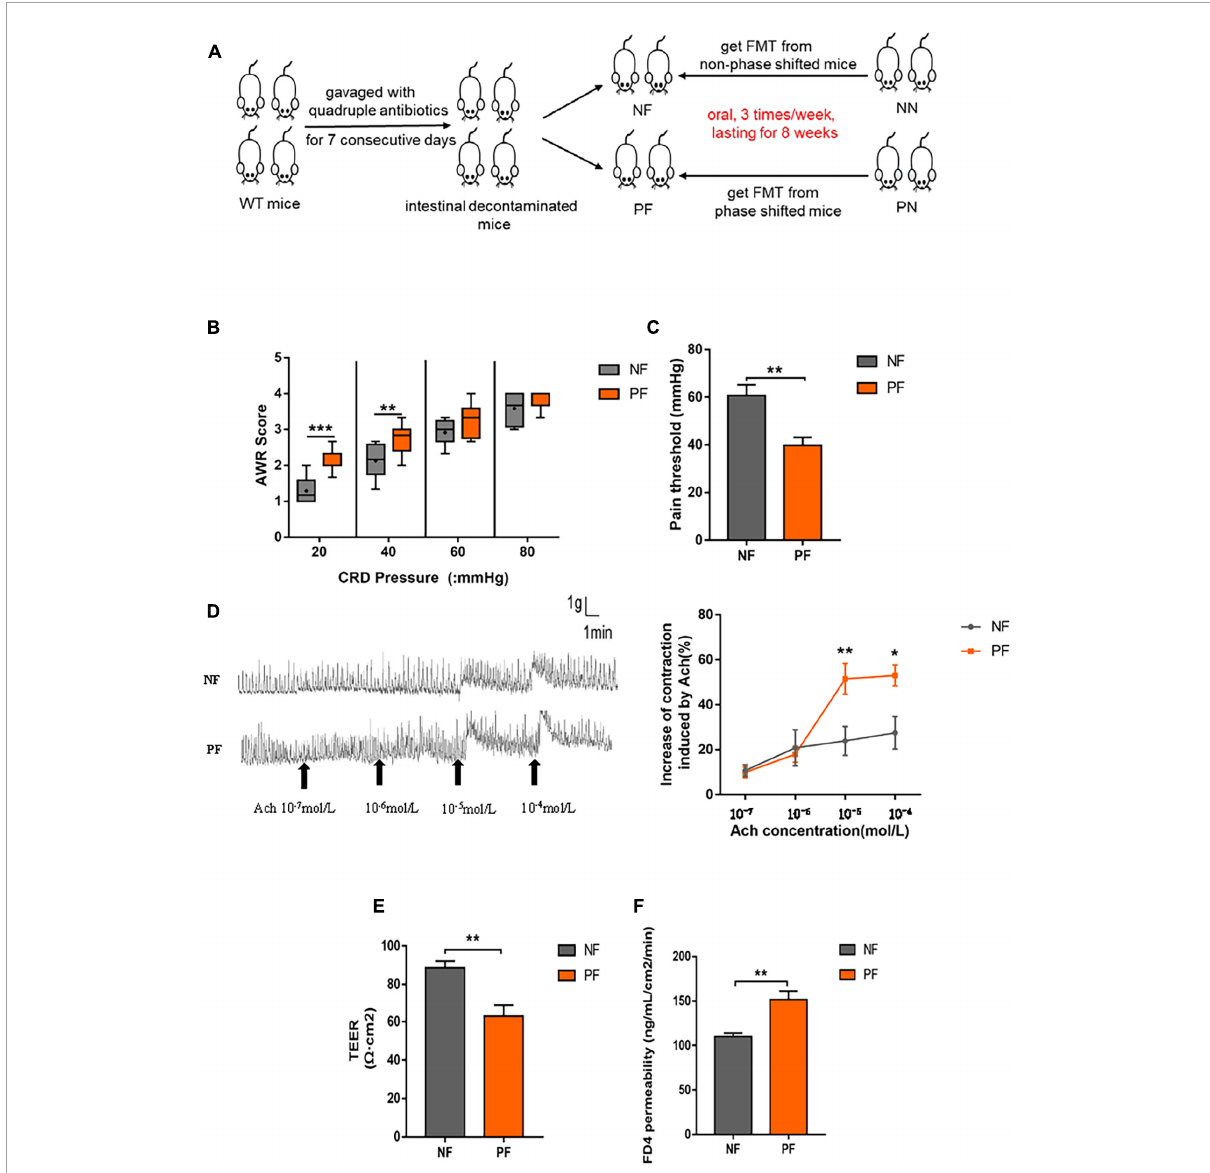
FIGURE6 Light/dark phase shift increases visceral hypersensitivity and intestinal permeability by modifying the gut microbiota. (A) Schematic of FMT. (B) AWR scores under each CRD pressure between the NF and PF groups, n = 6 per group. Data are presented as medians and 25th to 75th interquartile ranges. (C) The pain threshold of NF and PF groups. n = 6 per group. (D) Contraction curve of colonic muscle strips to Ach and Proportion of increase in AUC under different Ach concentrations of the NF and PF groups (compared to baseline of each group was calculated). n = 6 per group. (E) TEER of colonic mucosa. (F) Permeability of colonic mucosa to FD4. Data are expressed as the mean ± SEM. Comparison between two groups performed with a two-tailed Student’s t -test. * P < 0.05, ** P < 0.01, *** P < 0.001. NF, mice received FMT from the NN group; PF, mice received FMT from the PN group; FMT, fecal microbiota transplantation; AWR, Abdominal withdrawal reflex; CRD, Colorectal distension; Ach, Acetylcholine; TEER, Transepithelial resistance; FD4, FITC-dextran of